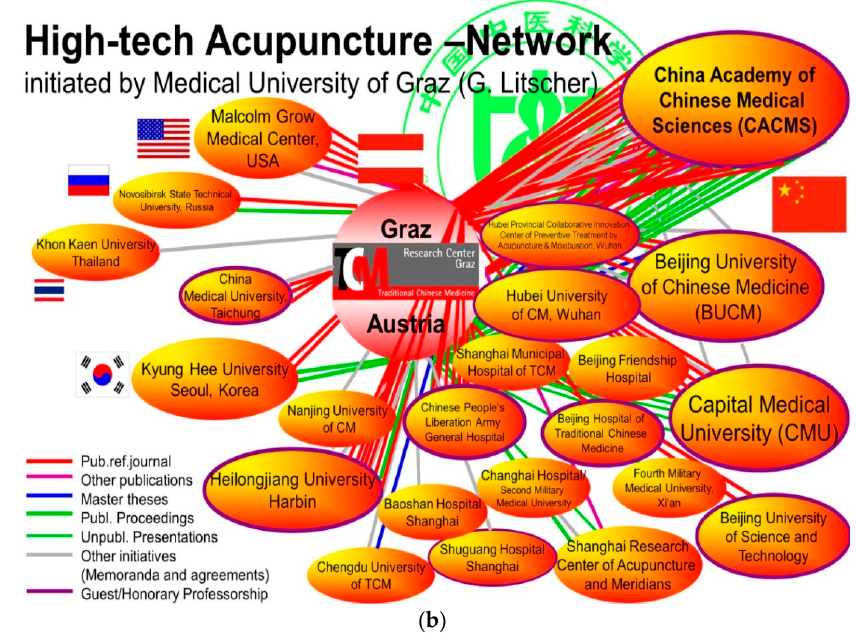
Figure 1. High-tech acupuncture network initiated in Graz ( a ) and current partners, including scientific information ( b ). CM: Chinese Medicine; TCM: Traditional Chinese Medicine.